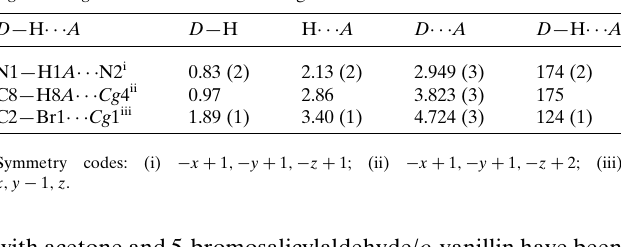
Table 1 Hydrogen-bond geometry (A˚ , (cid:3) ) for (I). Cg 1 and Cg 4 are the centroids of rings N2–N4/C11/C12 and C1–C6.